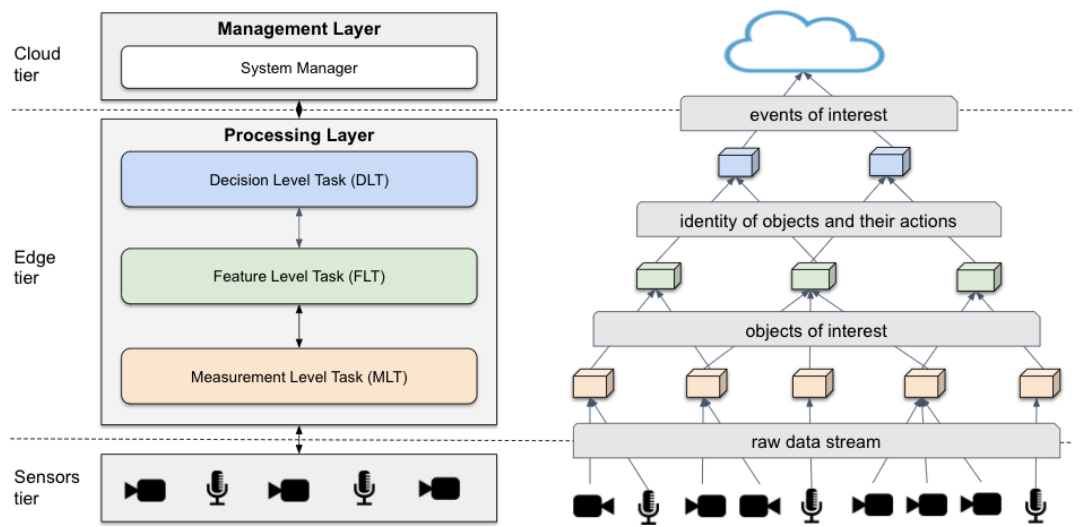
Figure 2. MELINDA Three-Tier Architecture